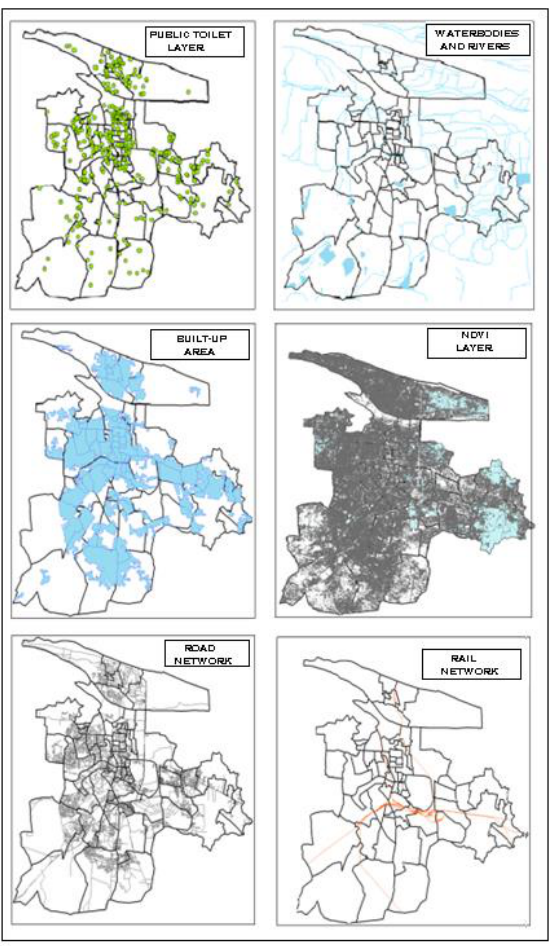
Figure 4: GIS Layers; a: Public Toilets; b: Rivers and water bodies; c: Road Network; d: Built-up Area; e: NDVI; f: Rail